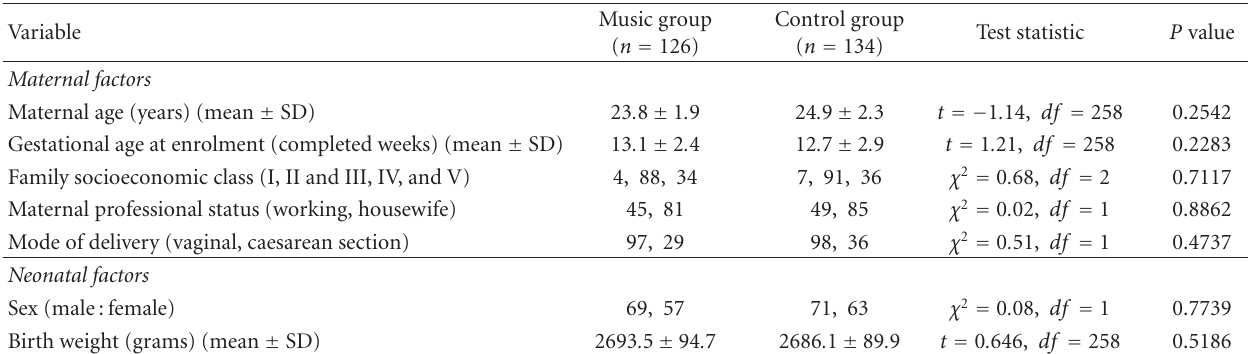
Table 1: Baseline comparisons of relevant maternal and neonatal variables between music and control